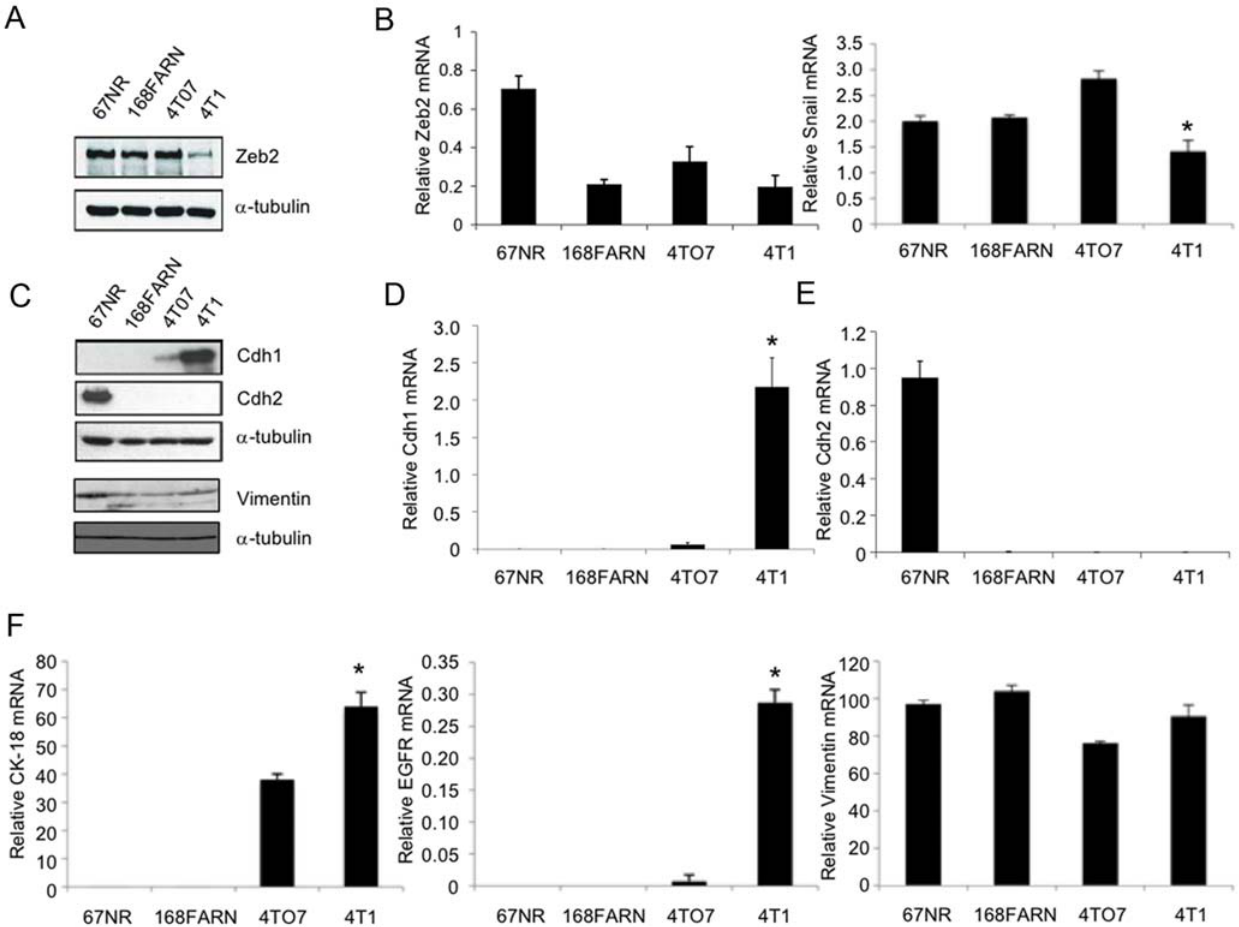
Figure 2. Protein expression of Zeb2 protein negatively correlates and E-cadherin positively correlates with miR-200 expression. (A) Zeb2 protein, analyzed by immunoblot relative to a -tubulin as a loading control, is significantly lower in 4T1 cells. (B) Zeb2 mRNA, analyzed by qRT- PCR and normalized to Gapdh, is higher in 67NR cells but similarly expressed in the other cell lines. Snail mRNA is somewhat lower in 4T1 cells than the other cell lines. (C–E) E-cadherin protein (C) and mRNA (D) expression is only detected in 4T1 cells, while N-cadherin protein (C) and mRNA (E) is restricted to 67NR cells. Vimentin protein (C) is expressed in all 4 cell lines, but expression is greater in 67NR cells, while vimentin mRNA is expressed at similar levels in all 4 cell lines (F). Cytokeratin-18 (CK-18) mRNA is expressed in 4TO7 and 4T1 cells, while Epidermal Growth Factor Receptor (EGFR) is limited to 4T1 cells (F). Protein was analyzed relative to a -tubulin by immunoblot and mRNA was quantified by qRT-PCR relative to Gapdh. Levels of protein and mRNA for both cadherins changed in parallel. The qRT-PCR results represent the mean and standard deviation from three independent experiments (*p , 0.01, **p , 0.001).